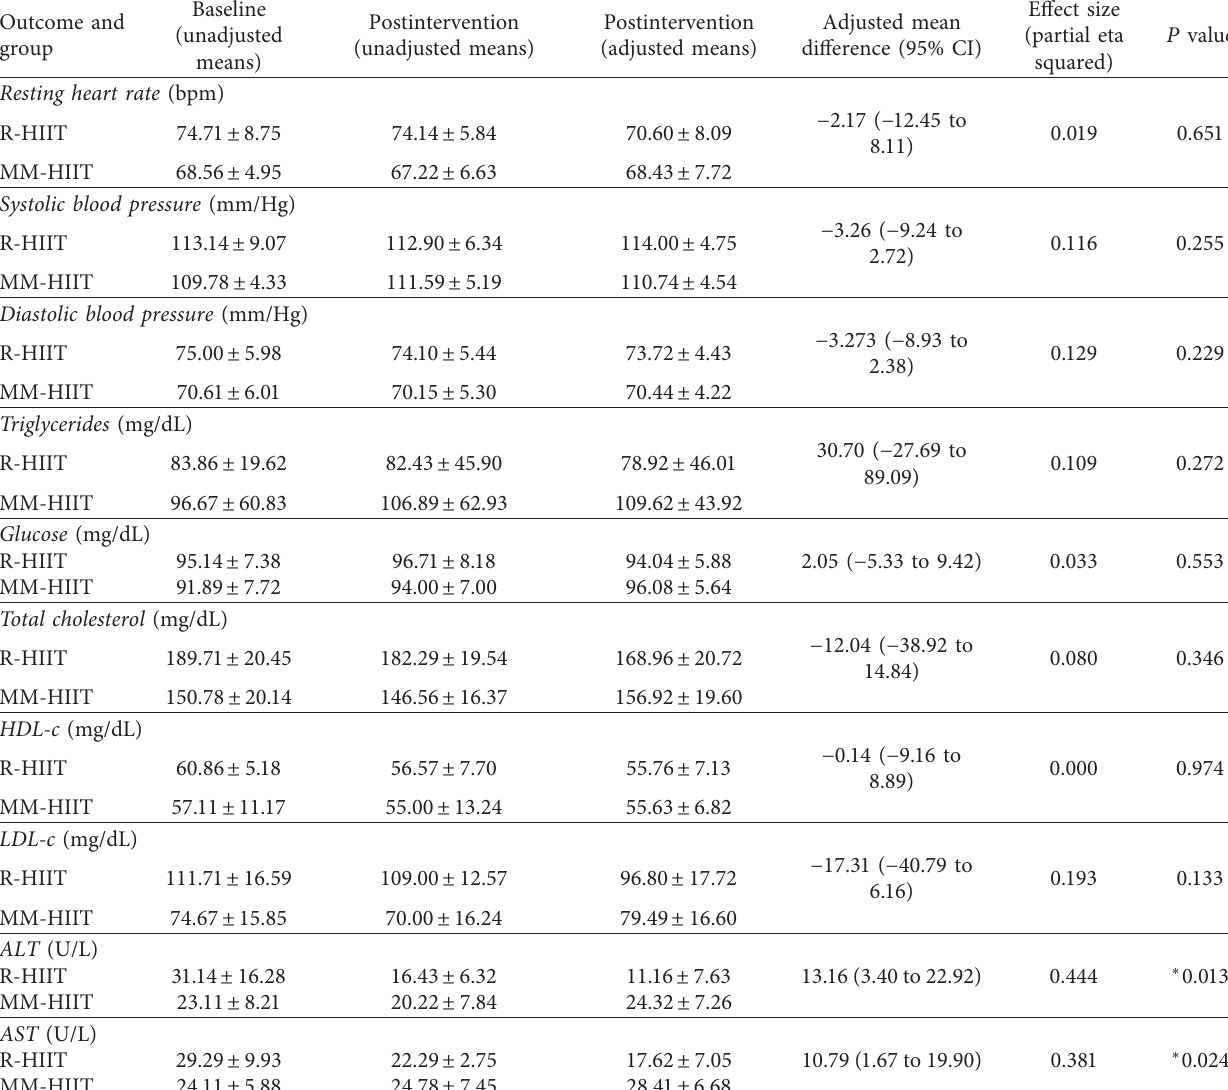
Table 2: Summary of changes in cardiometabolic variables over time between R-HIIT ( n � 7) and MM-HIIT ( n � 9) groups from ANCOVA. Outcome